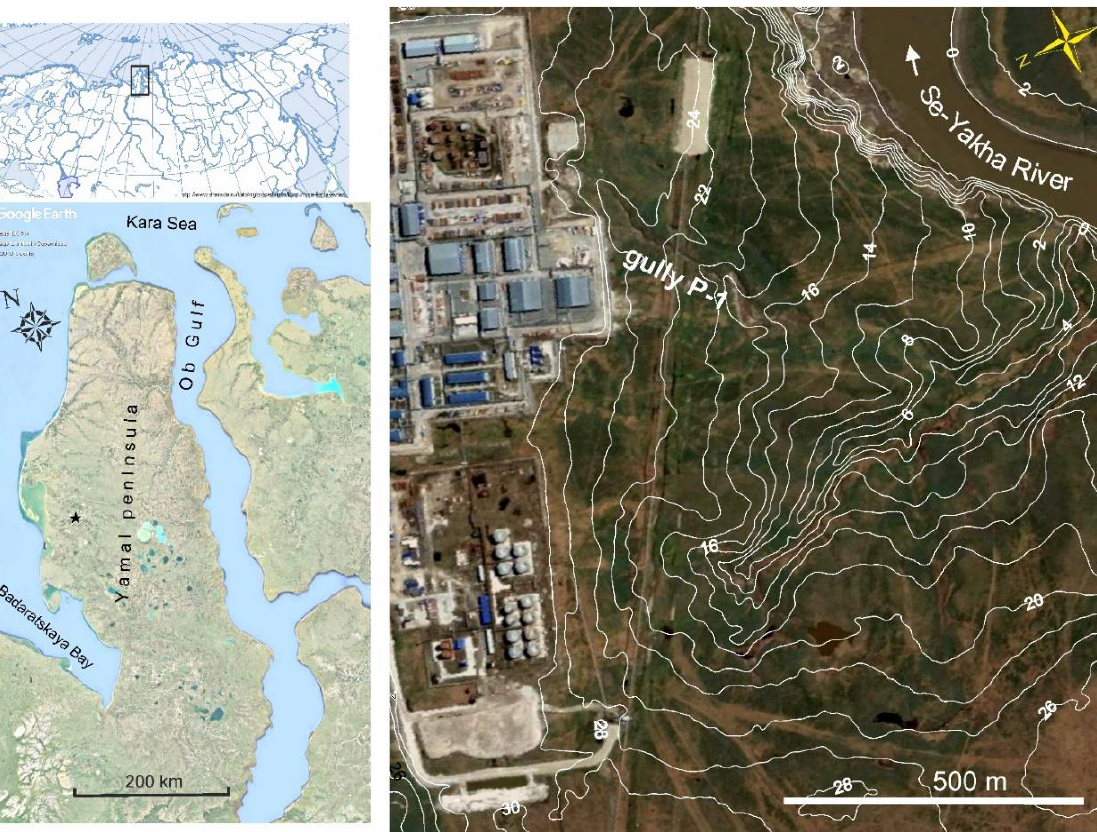
Figure 1. The catchment of the large unnamed stable gully with tributary gully P-1 on the Yamal peninsula, Russia (the image of 27 June 2016 from Google Earth). The star on the left part of the figure shows the catchment position.